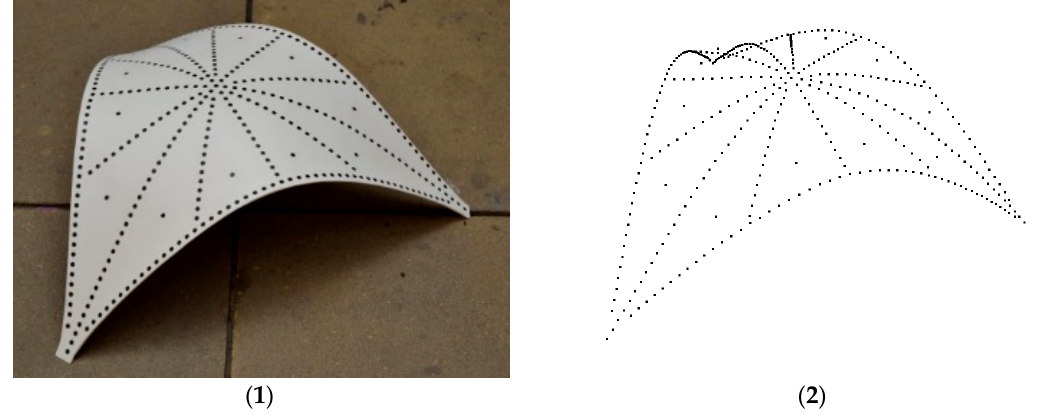
Figure 15. Photogrammetric procedure: ( 1 ) scale model; ( 2 ) computed 3D coordinates.